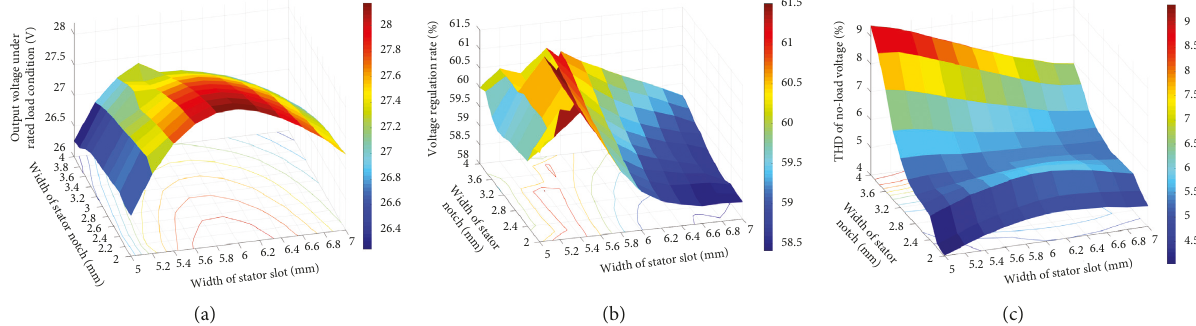
Figure 11: Variation diagrams of generator output performance with different stator slot widths and different stator notch widths: (a) output voltage under rated load condition; (b) voltage regulation rate; (c) THD of no-load